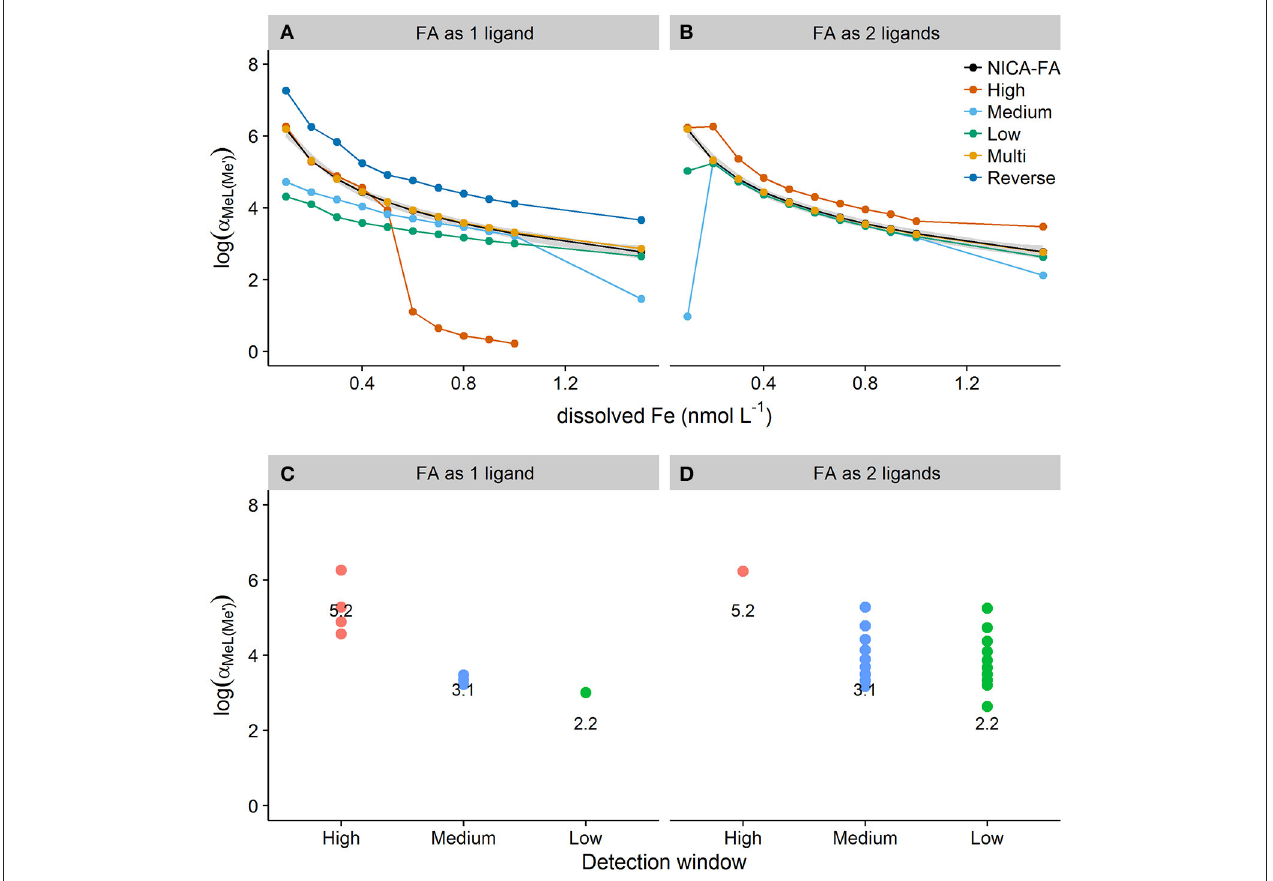
FIGURE 6 | The top panel (A,B) shows side reaction coefficients calculated from the product of the conditional stability quotient and the unbound or excess ligand quotients obtained for simulated titrations of seawater containing a heterogeneous distribution of binding sites and dissolved iron concentrations between 0.1 and 1.5 nmol L − 1 . Titrations were simulated applying high, medium and low detection windows or reverse and multwindow methods and assuming one (A) or two (B) ligands. Side reaction coefficients calculated directly from the ratio of bound to unbound metal obtained for NICA-FA in visual MINTEQ are shown in black. The 99% confidence interval for the NICA-FA side reaction coefficient is shown as the gray shaded area. The bottom panel (C,D) shows plots of the subset of data from (A,B) and excess L i were within the 99% confidence interval of NICA-FA side reaction coefficients for the one where side reaction coefficients determined from log K cond MeL i ligand assumption (C) and the two ligand assumption (D) . The value of log( α FeNN 3( Fe ′ ) ) for each detection window is overlaid as text onto the